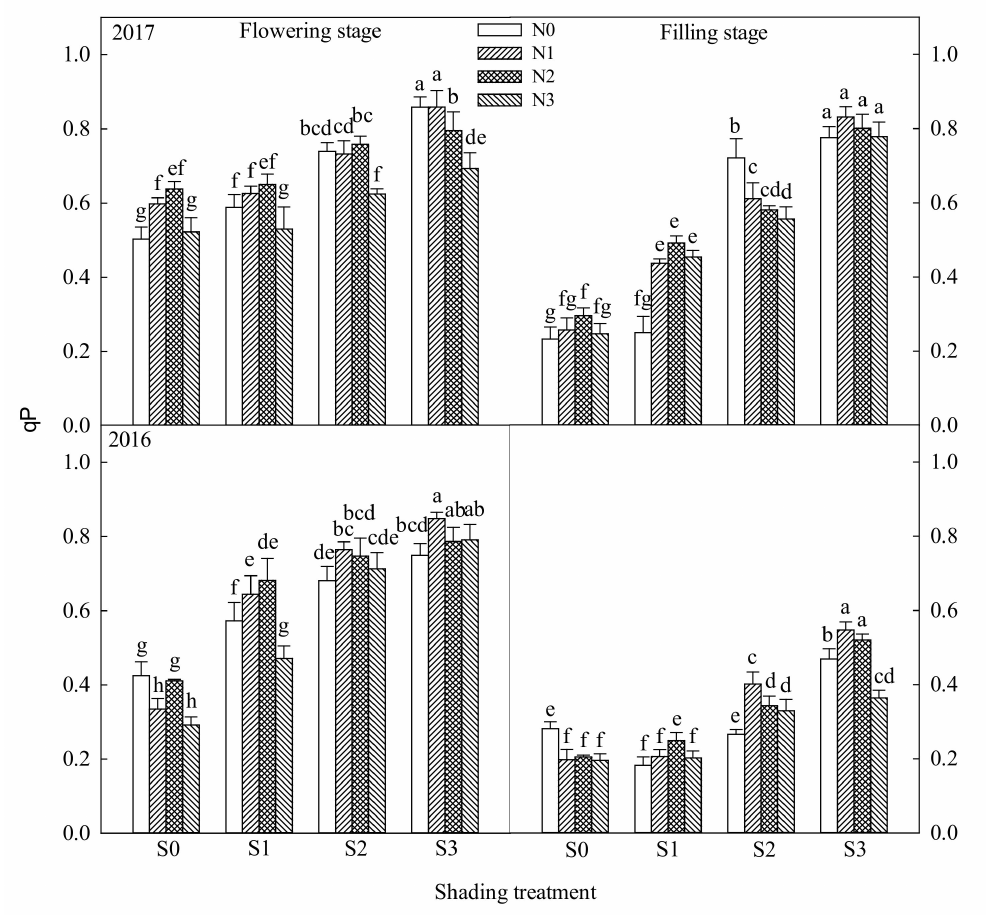
Figure 8. Effect of light and nitrogen treatment on the photochemical quenching coefficient (qP) of wheat. Bars indicate SD (n = 3). Values within columns followed by the same letter are statistically insignificant at the 0.05